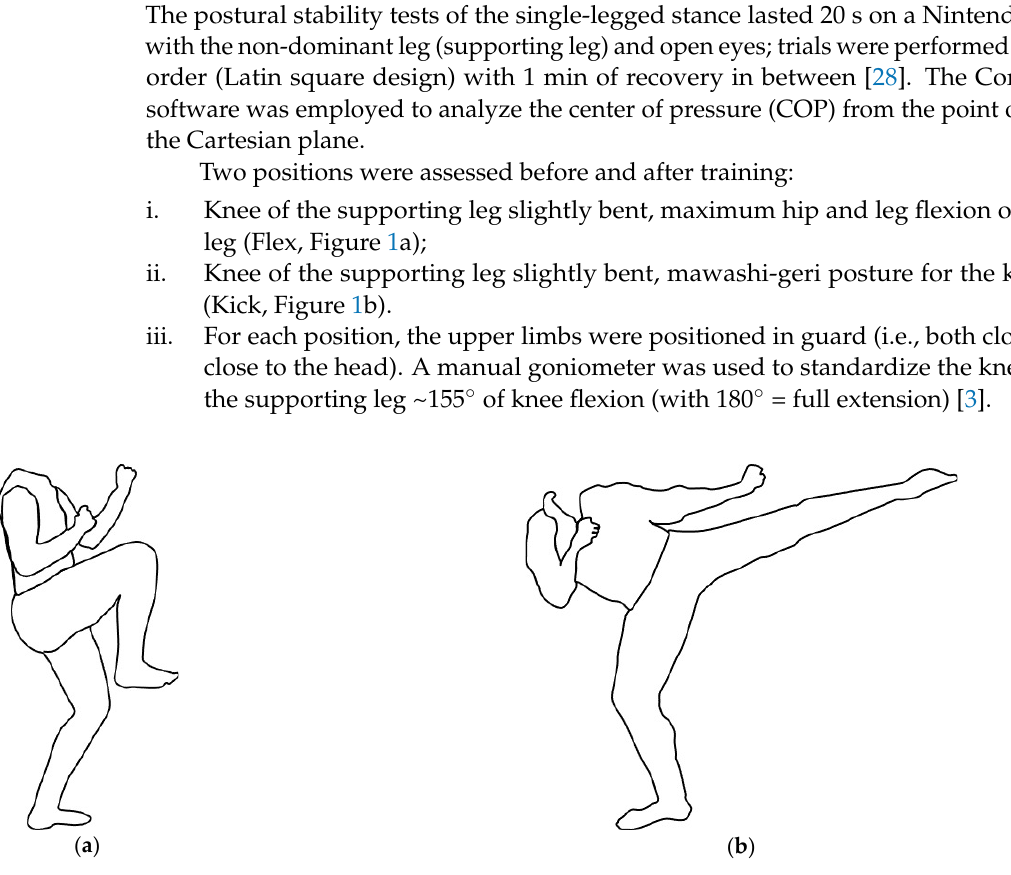
Figure 1. Testing position for single-leg balance. ( a ) Flex: knee of the supporting leg slightly bent, maximum hip and leg flexion of the other leg; ( b ) Kick: knee of the supporting leg slightly bent, mawashi-geri posture for the kicking leg. Note: training was performed as in (b).